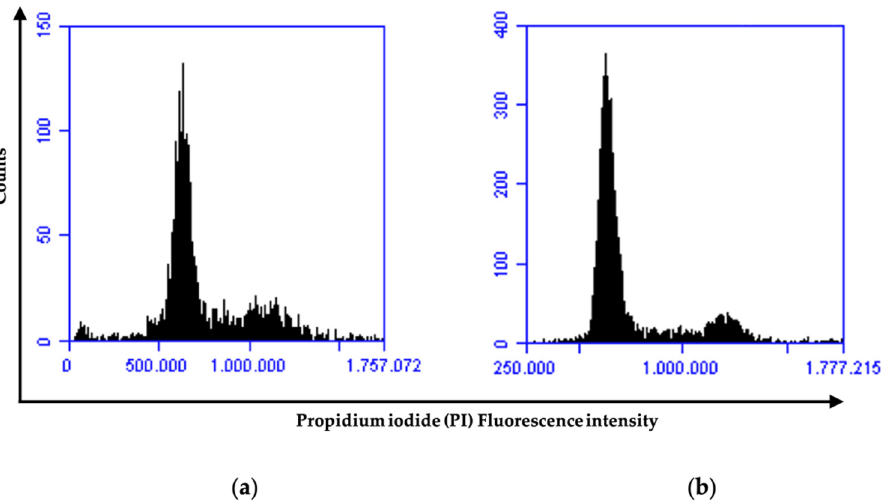
Figure 2. Cell cycle of blank ( a ) and compound 2f ( b ). Note that 250.000; 500.000; 1.000.000; 1.757.072 and 1.777.215 correspond to 250,000; 500,000; 1,000,000; 1,757,072; 1,777,215.